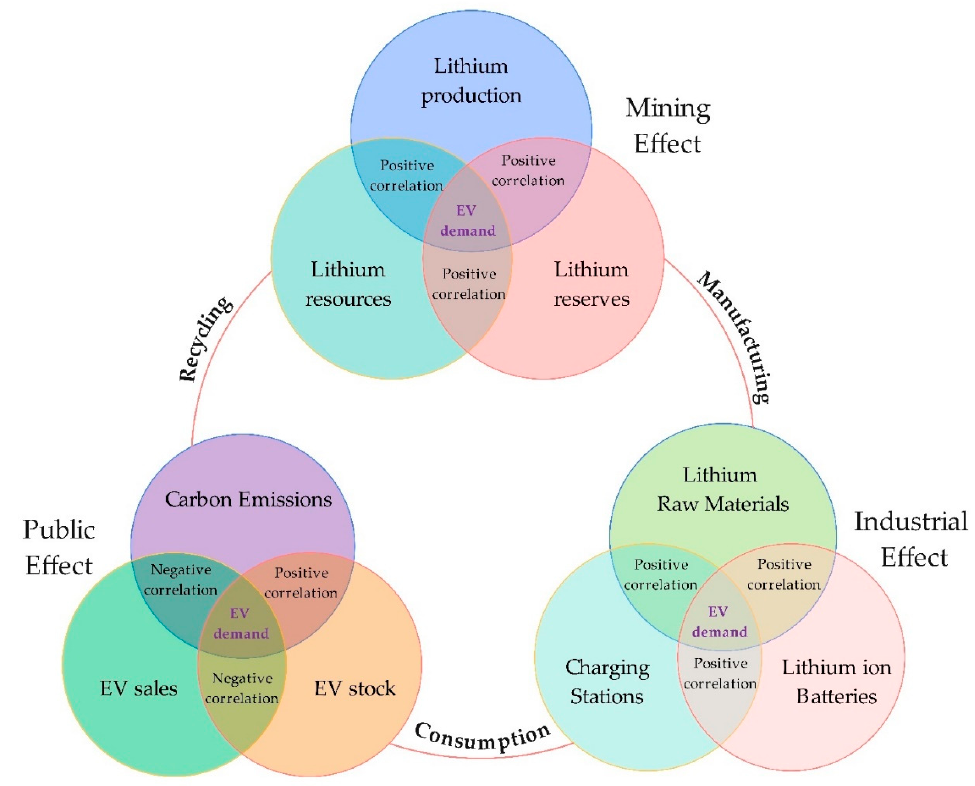
Figure 6. Closed loop of lithium supply chain and its transformation toward EVs.